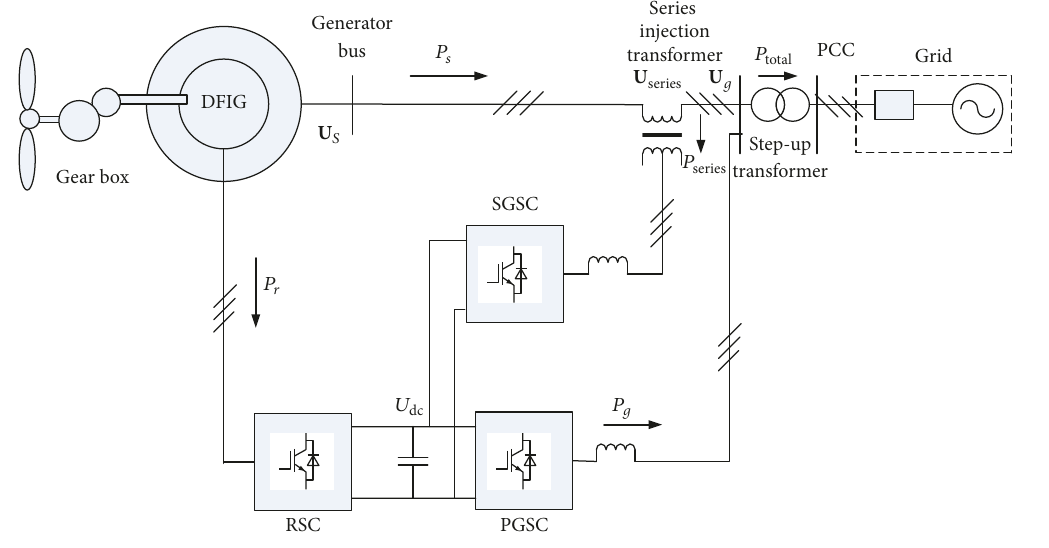
Figure 6: Configuration of a DFIG with SGSC